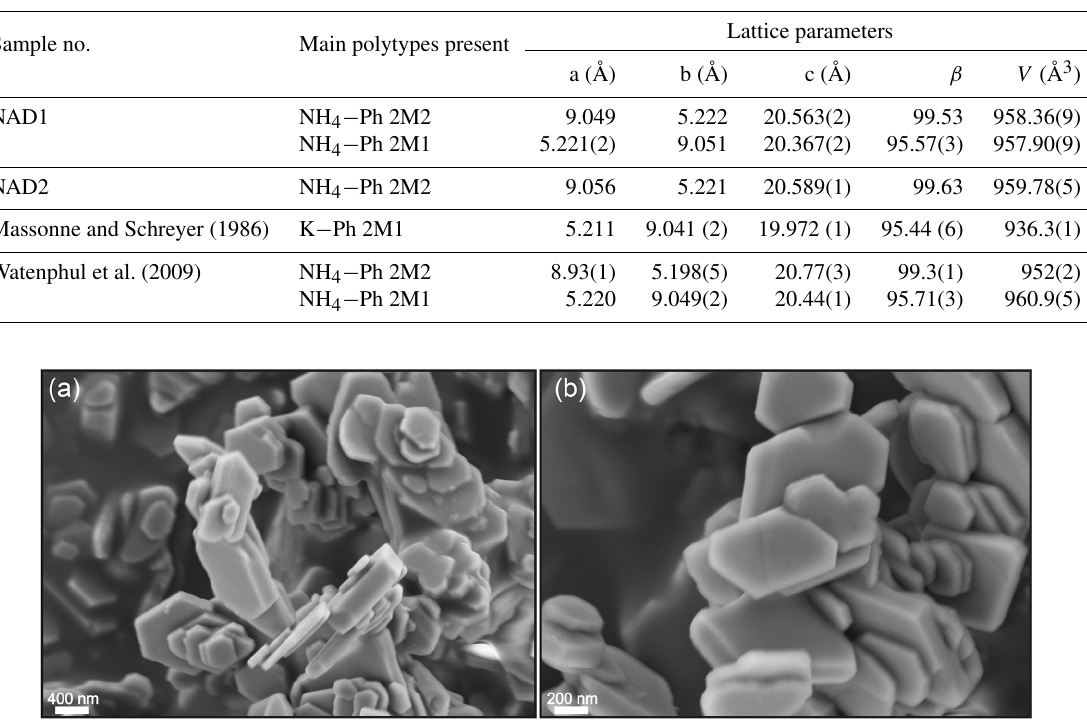
Figure 2. FE-SEM micrographs (secondary electron image) of run products from our piston-cylinder experiment NAD1 showing (a) the thin flakes of well-crystallised NH 4 -phengite and (b) the pseudohexagonal cross